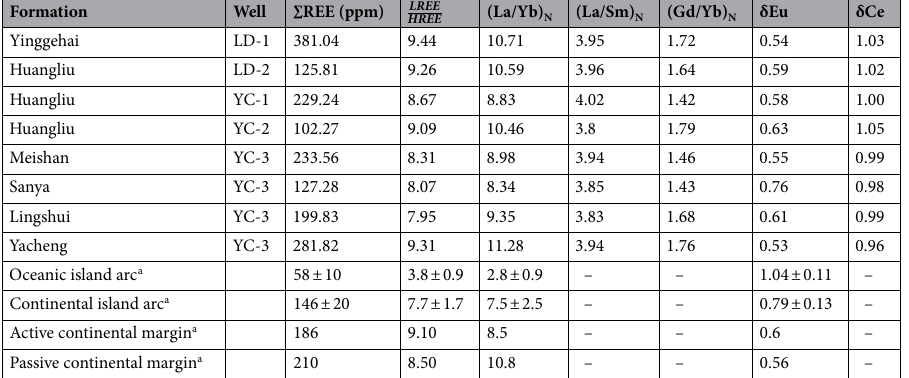
LREE HREE is the light to heavy rare